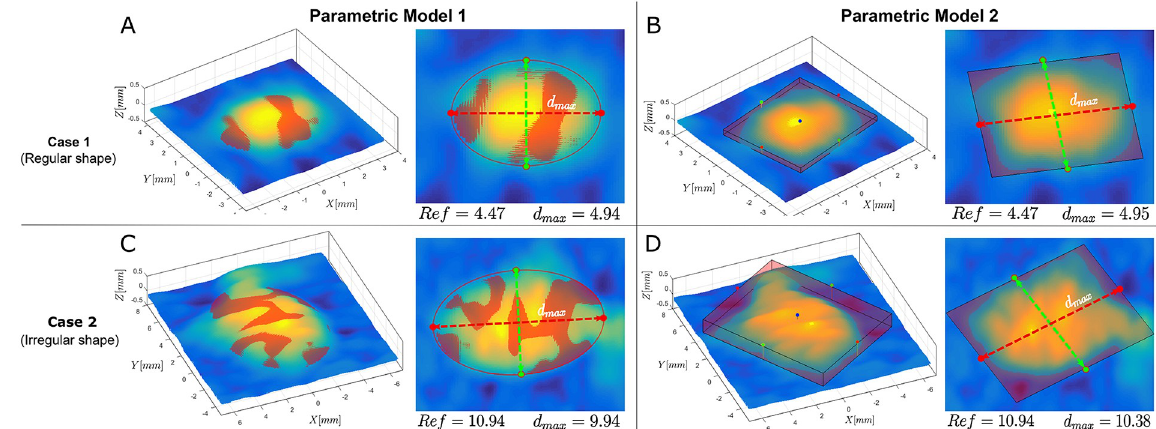
Fig 8. The results of fitting a regular-shaped wheal with (A) the parametric model 1 and (B) the parametric model 2. Both models are in numerical agreement and slightly overestimate the reference measurement of 4.47 mm. For an irregular-shaped wheal the result from ( C ) parametric model 1 and ( D ) parametric model 2 differ by 0.44 mm. However, the result from parametric model 2 results in a more accurate estimation of the longest